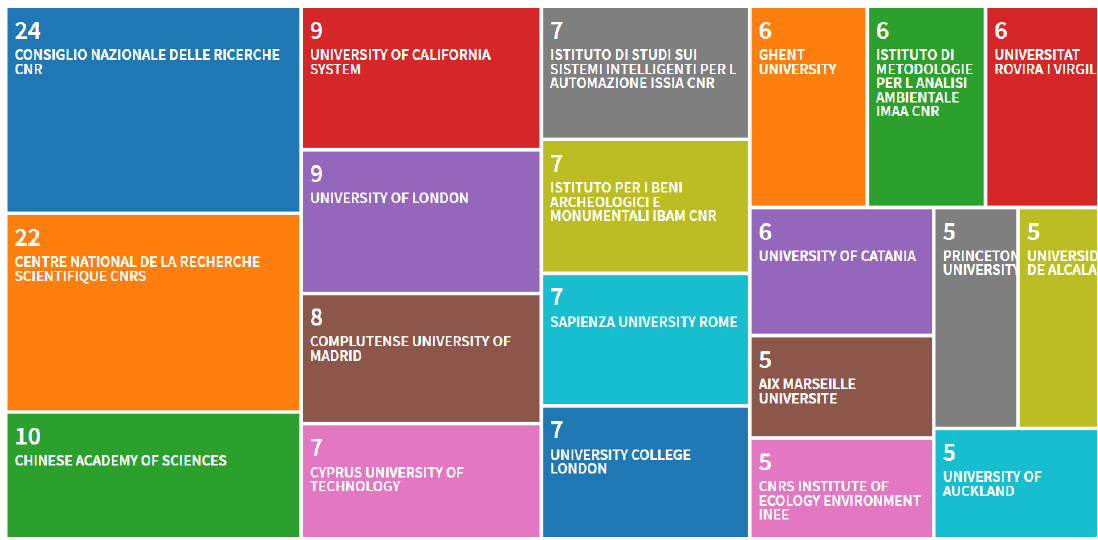
Figure 4. Top institutions producing archaeological MI research contained in Web of Science. These do not represent the total number of published studies, but illustrate disparities within certain journals (source, Web of Science). Results from Microsoft Academic indicate similar results.